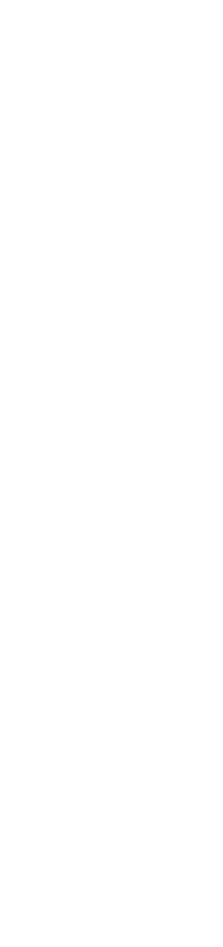
Figure 8. Analysis of global temperature responses in the NorESM model. (a) The volcanic forcing (red) normalised such that the largest spikes are approximately equal to the spikes of the response signal (black). (b) The red curve in (a) + the control-run temperature signal. (c) Structure functions (of cumulative sum) of volcano forcing. (d) Scaling function derived from (c) . (e) Structure functions of the response to volcanic forcing. (f) Scaling functions derived from (e) . (g) Structure functions of the signal in (b) . (h) Scaling function derived from (g) . The red line arises from fitting straight lines in the entire scale range plotted, 4–128 years. The blue line is from fitting only in the scale range 16–128 years. It shows weak intermittency in both cases, as well as that estimated intermittency depends on the scale range chosen for fitting. The difference in curvature (reduction of intermittency) between (d) and (h) is exclusively caused by the addition of the internal noise represented by the control run, and the similarity between (f) and (h) indicates that the internal variability is the main cause of reduced intermittency in the response to volcanic